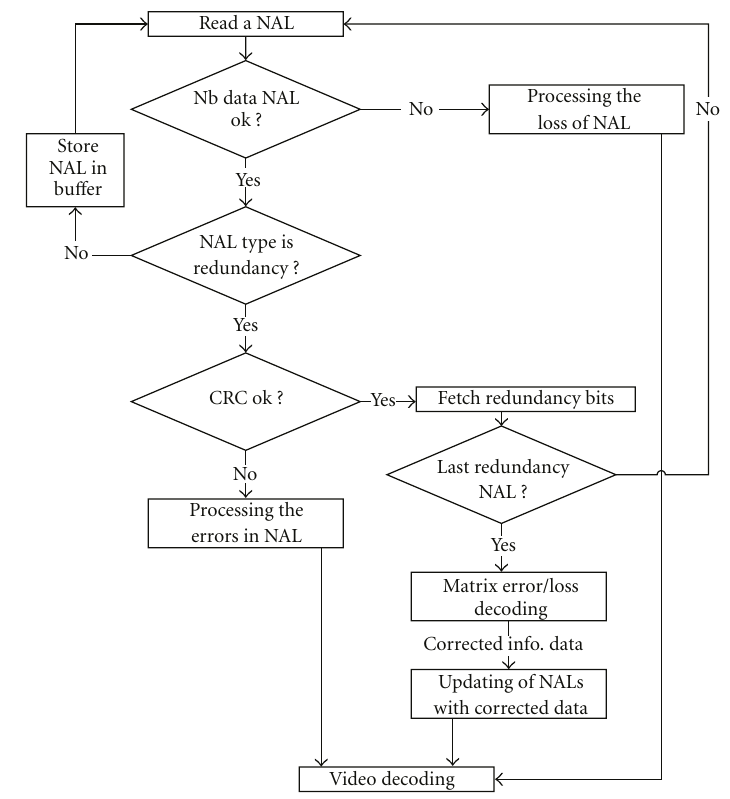
Figure 8: N / M redundancy decoding process.